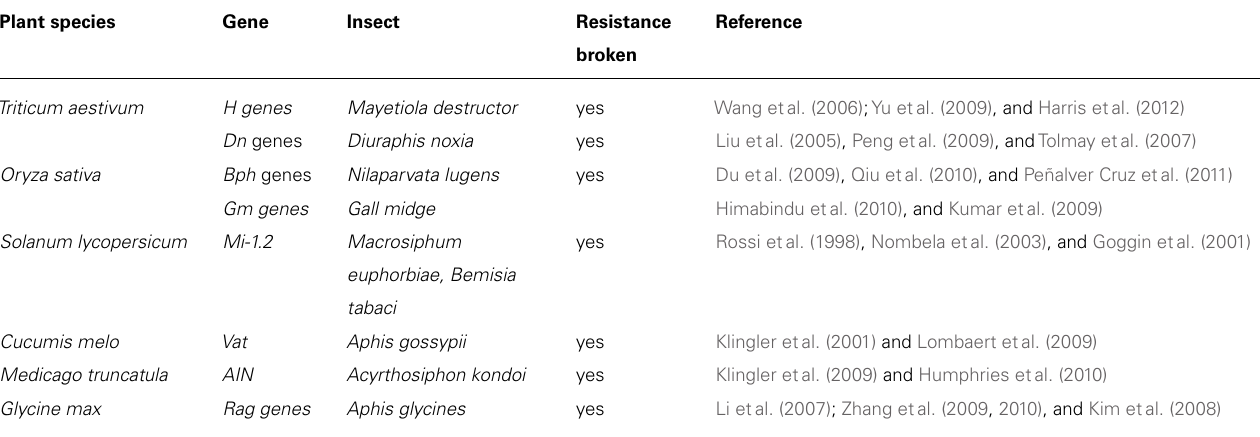
Table 1 | Overview of R-genes mediating insect resistance (adapted from Broekgaarden etal., 2011, with permission). Plant